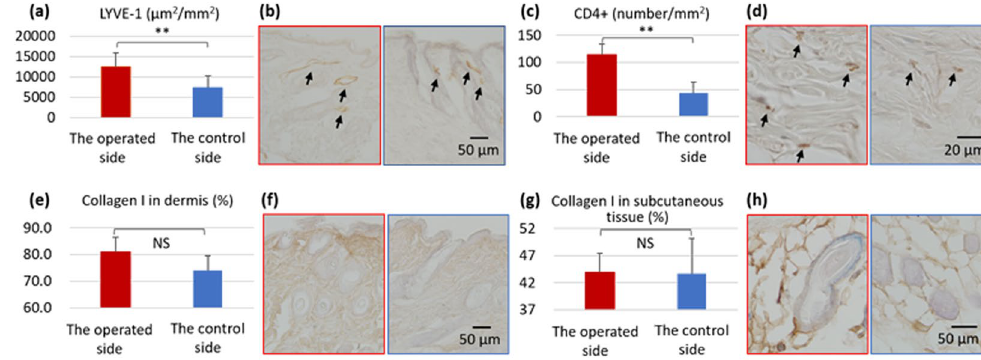
Figure 4. Histological evaluation of the hindlimb after lymphadenectomy on day 60. ( a ) The area of capillary lymphatics in 1 mm 2 of the dermis. ( b ) Representative photomicrographs of LYVE-1 immunohistochemical staining in the operated side (left) and control side (right). ( c ) The number of CD4 + cells in the dermis and subcutaneous tissue in 1 mm 2 . ( d ) Representative photomicrographs of CD4 immunohistochemical staining in the operated side (left) and control side (right). ( e ) The ratio of collagen I in the dermis. ( f ) Representative photomicrographs of collagen I immunohistochemical staining in the operated side (left) and control side (right). ( g ) The ratio of collagen I in subcutaneous tissue. ( h ) Representative photomicrographs of collagen I immunohistochemical staining in the operated side (left) and control side (right). Black arrows; lymphatics ( b ), CD4 + cells ( d ). N = 5 in a, c, e, and g. ** P < 0.01 versus the control (paired t